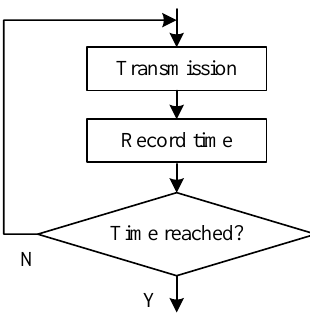
Figure 13. Processing flow chart of the open-loop active transmission mode.